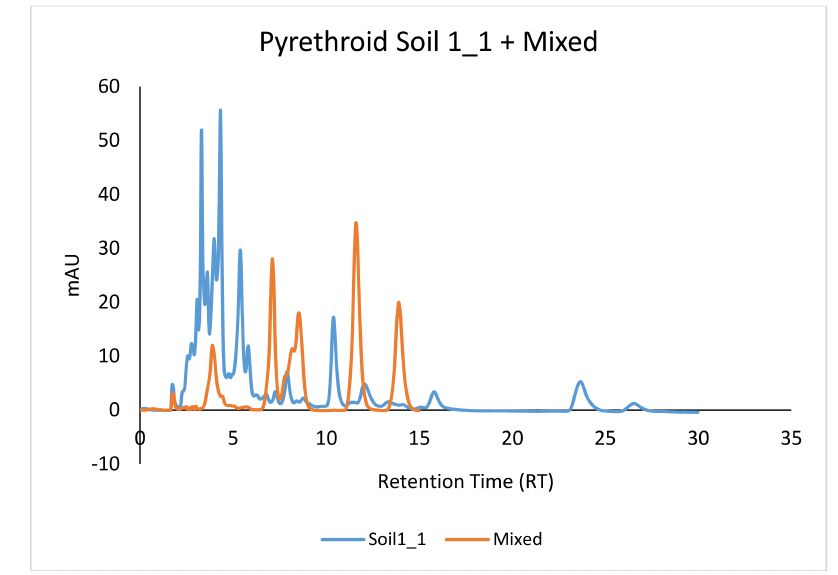
Figure 6. Retention times of the active ingredients detected in soil